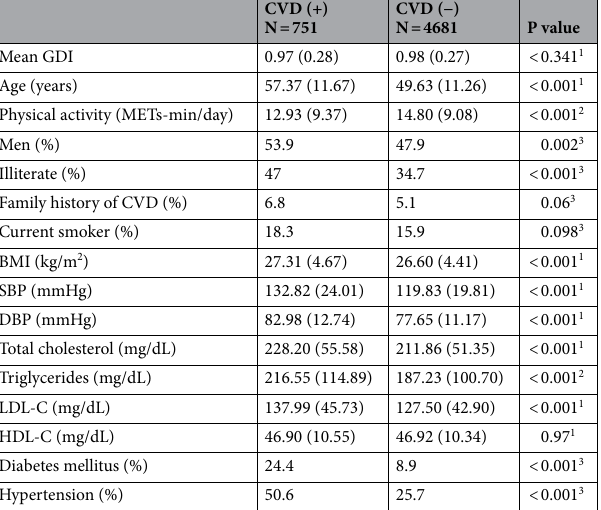
Dietary intakes